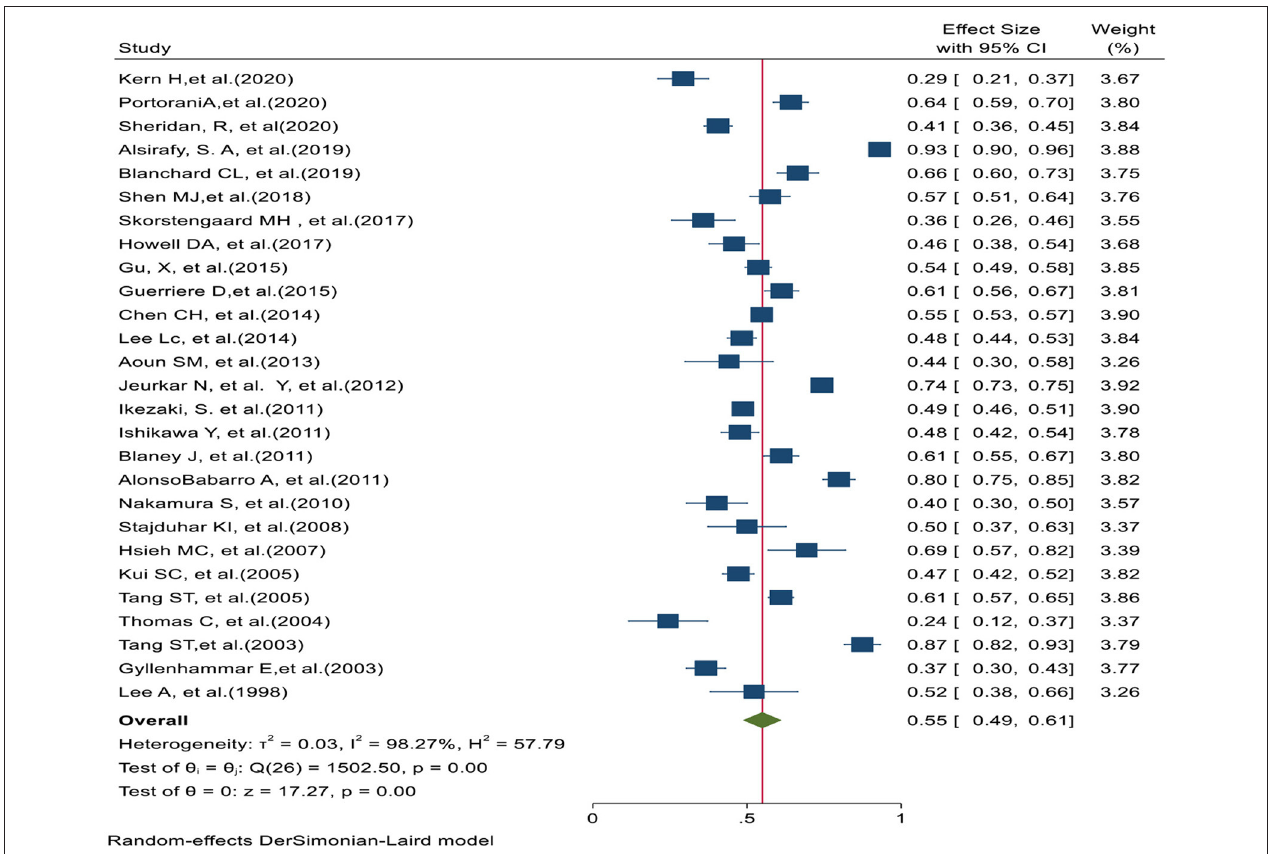
FIGURE 2 | Forest plot for the prevalence of Home-based PPOD.